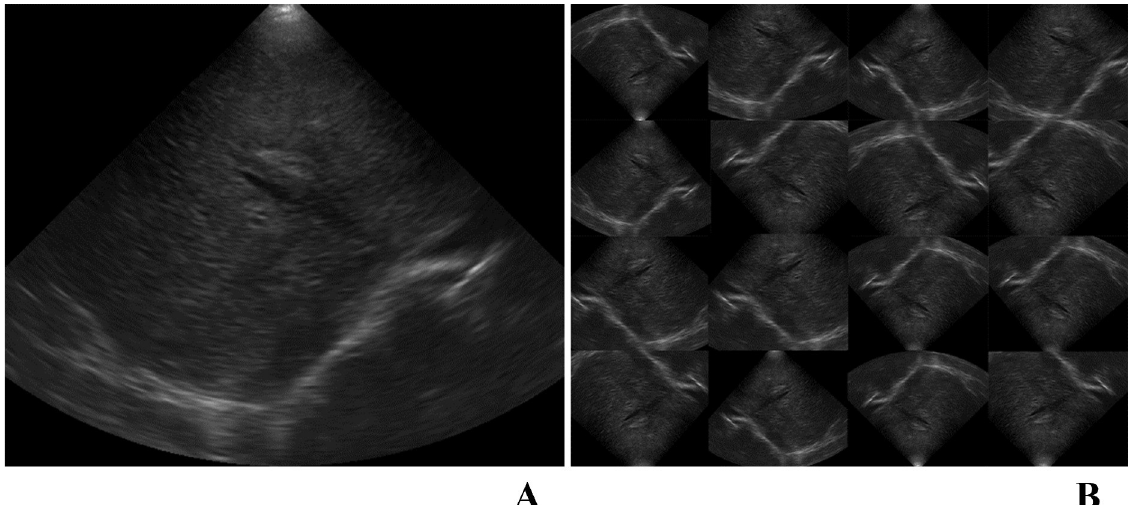
Fig 3. Examples of US images from a patient with BA. A. An original US image. B. The images after data augmentation.